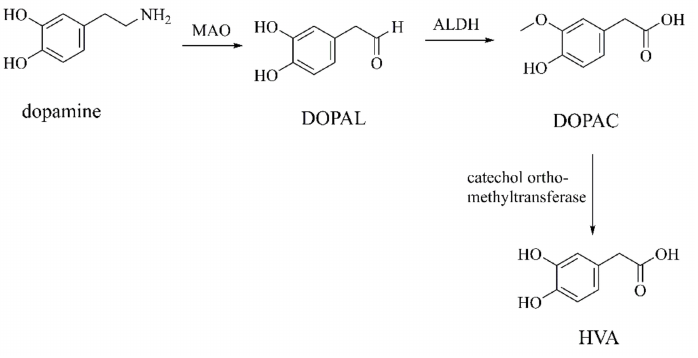
Figure 14. Dopamine oxidized by monoamine oxidase (MAO) [93,100].